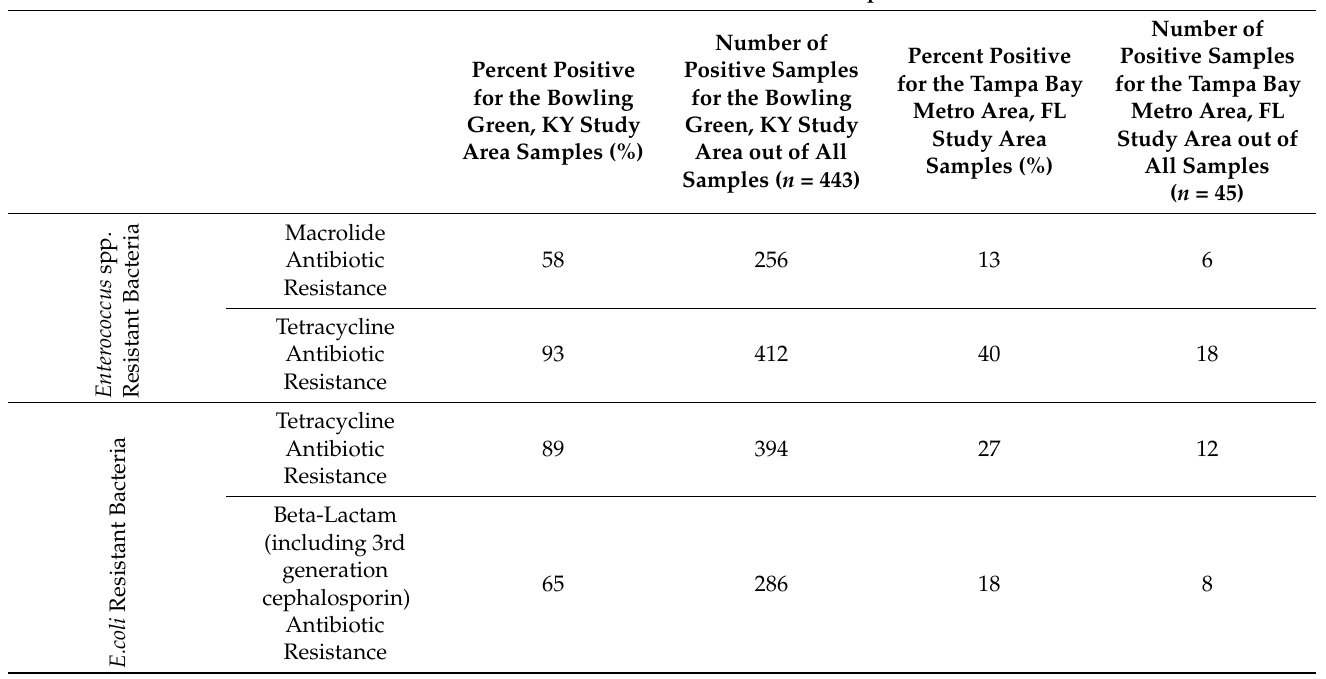
Table 1. Prevalence of antibiotic resistance for all samples in the Bowling Green, KY and Tampa Bay Metropolitan Area, FL study areas. Percent Positive of Antibiotic Resistant Samples Number of Number of Positive Samples Percent Positive Positive Samples Percent Positive for the Tampa Bay for the Tampa Bay for the Bowling for the Bowling Metro Area, FL Metro Area, FL Green, KY Study Green, KY Study Study Area out of Study Area Area out of All Area Samples (%) All Samples (%) Samples ( n = 443)